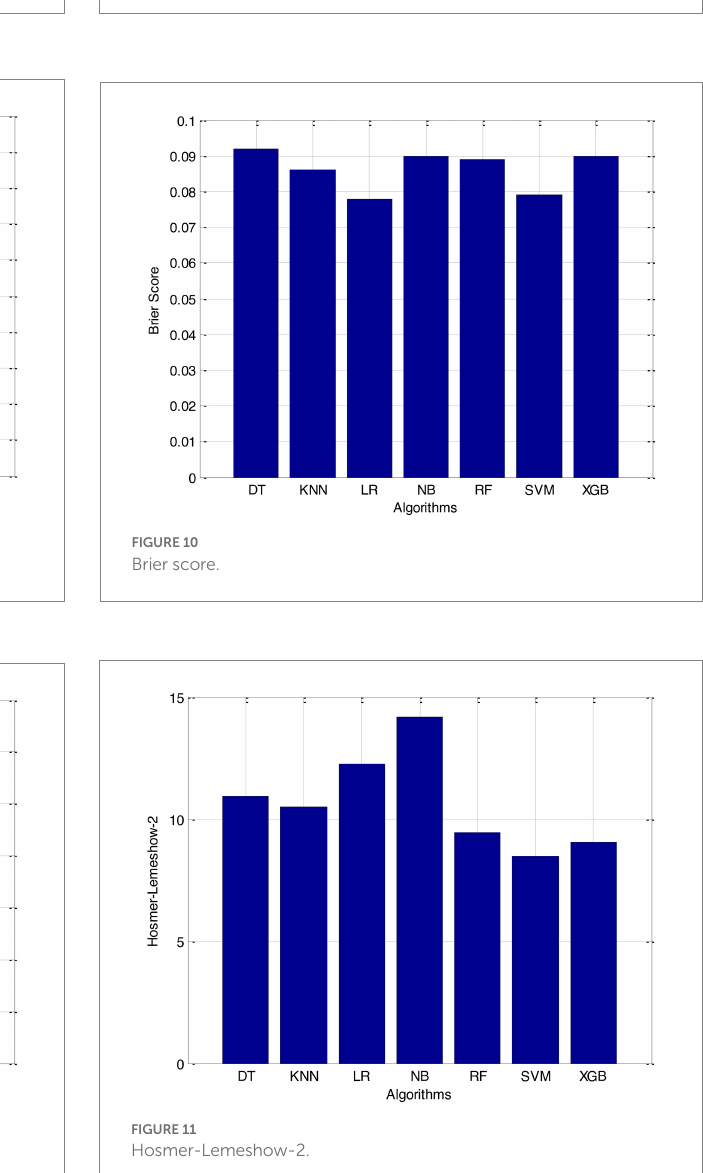
FIGURE 9 High-risk patients (%).